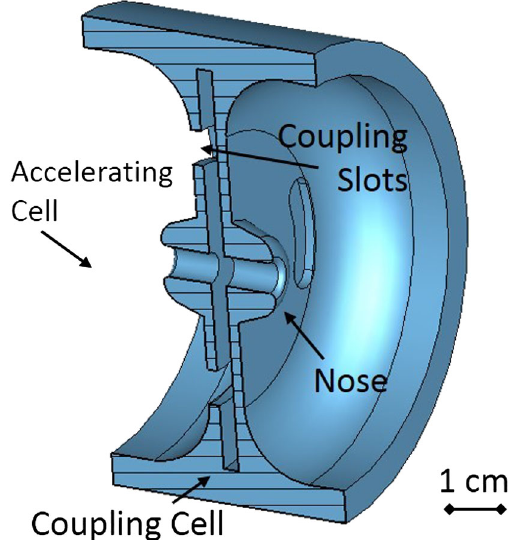
FIG. 2. Sketch of the S -band nose-cone cavity geometry. The nose-cone increases acceleration efficiency. The electromag- netic energy builds up in the accelerating cells through the coupling